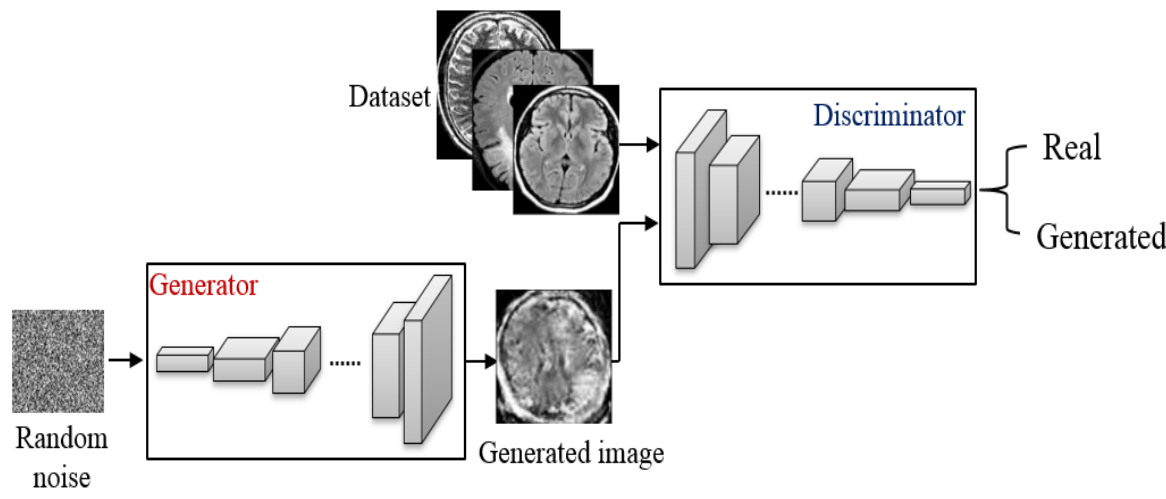
Figure 5. The proposed architecture of the DCGANs to generate MRI images.